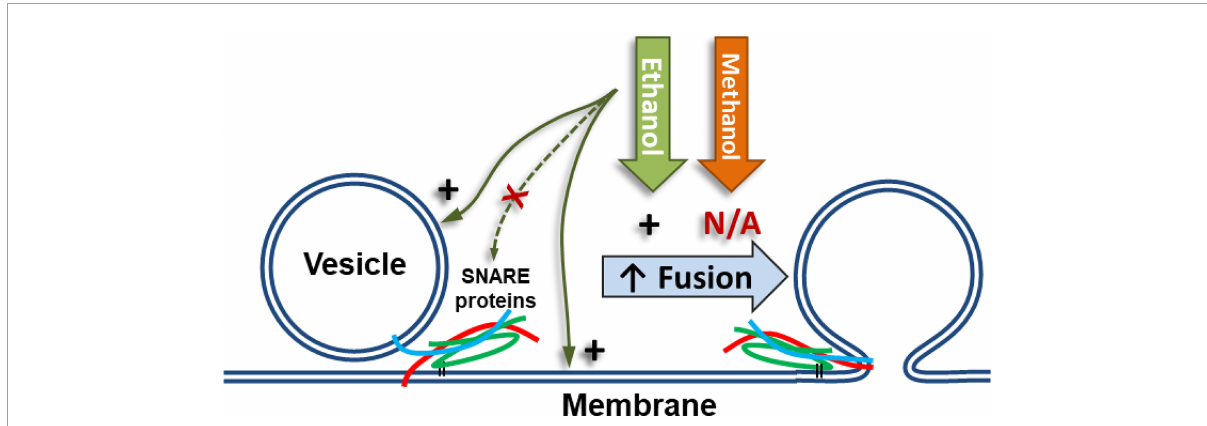
GRAPHICALABSTRACT Low doses of ethanol excite fusion of vesicles to a membrane in a model system of neurotransmitter release. At these same doses, methanol does not increase fusion. Our data demonstrates that ethanol’s effect is mediated through the lipids in the vesicle or planar membrane or both, but not through SNARE proteins (red, cyan, and green